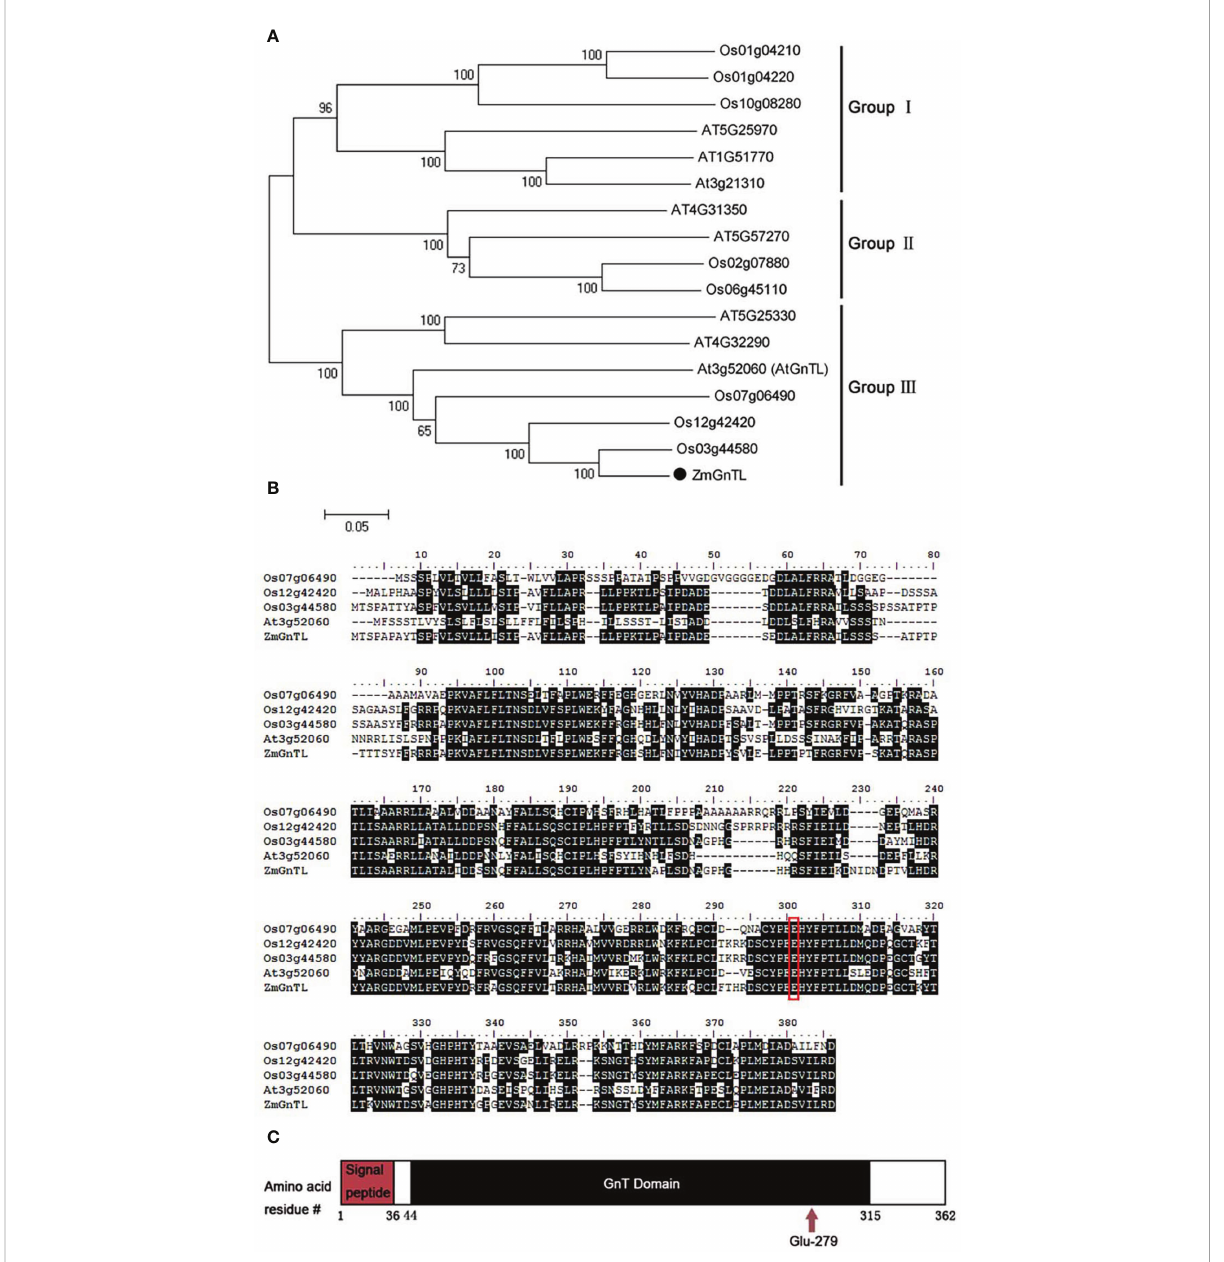
FIGURE 4 Sequence analysis of ZmGnTL . (A) Clustering analysis with related genes from rice and Arabidopsis . (B) Multiple sequence alignment analysis. (C) Pfam database predicted conserved